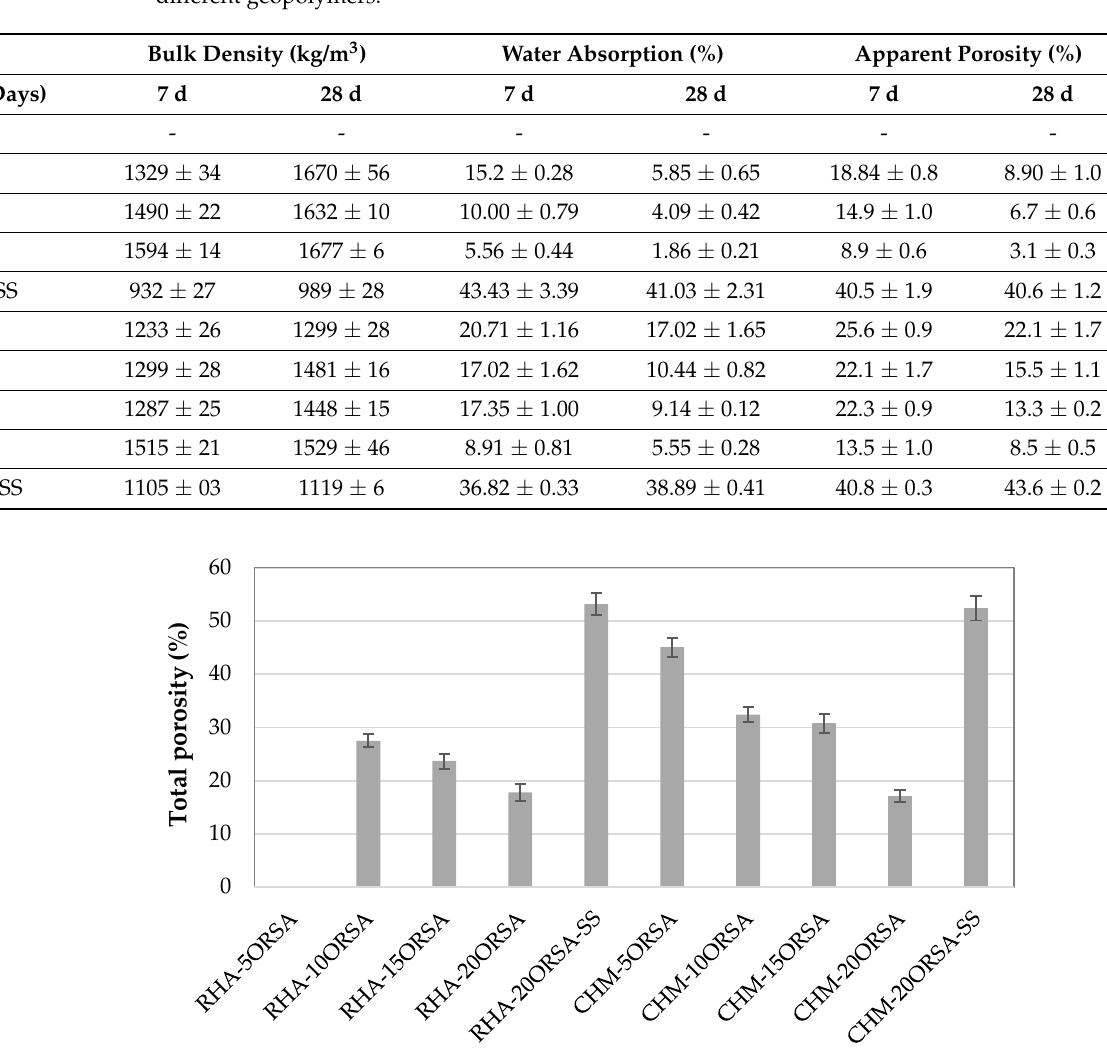
Figure 5. Total porosity of geopolymers at 28 days of curing.